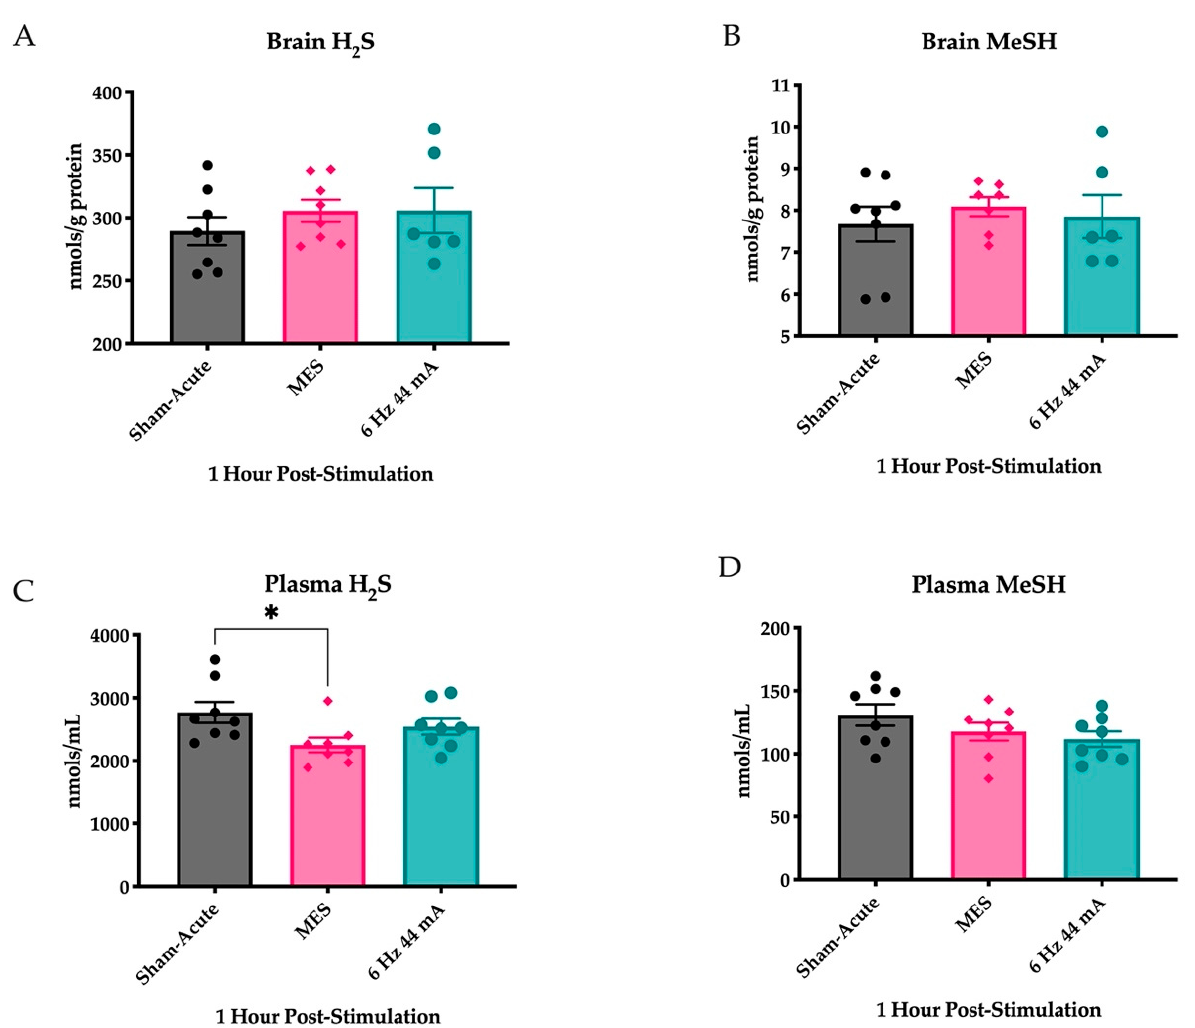
Figure 1. Acutely evoked seizures do not lead to significant changes in H 2 S levels in isolated whole brain tissues but do lead to changes in H 2 S levels in plasma 1 h after electrical stimulation of male CF-1 mice (n = 8 mice/stimulation group). Data are presented as mean +/ − S.E.M. ( A ) The levels of H 2 S are not significantly altered in isolated whole mouse brains 1 h after transcorneal stimulation to induce either an MES generalized tonic–clonic seizure or 6 Hz 44 mA focal seizure. ( B ) The levels of MeSH are not significantly altered in isolated whole mouse brains 1 h after transcorneal stimulation to induce either an MES generalized tonic–clonic seizure or 6 Hz 44 mA focal seizure. ( C ) The levels of H 2 S are significantly reduced in plasma collected 1 h after transcorneal stimulation with an MES generalized tonic–clonic seizure. There is no significant reduction in H 2 S levels in the plasma of mice that received a 6 Hz 44 mA focal seizure stimulation. * Indicates significant difference from sham-stimulated mice, p < 0.05. ( D ) The levels of MeSH are not significantly altered in the plasma of mice collected 1 h after transcorneal stimulation to induce either an MES generalized tonic–clonic seizure or 6 Hz 44 mA focal seizure.